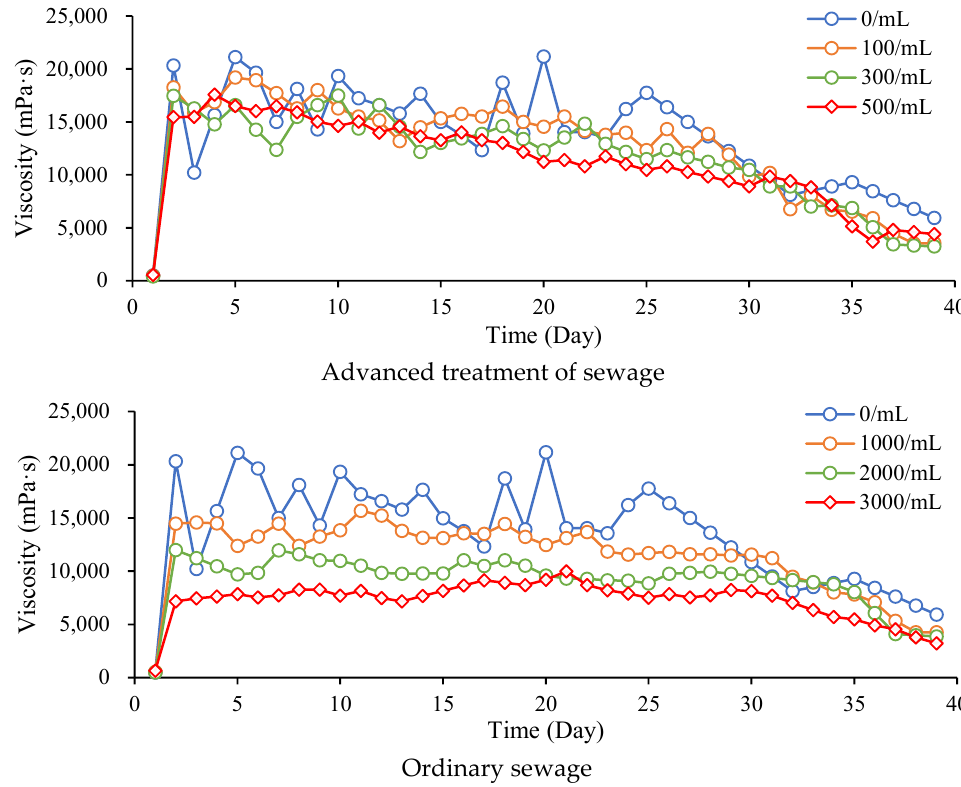
Figure 4. The effect of bacterial content on the gelation of weak gels.